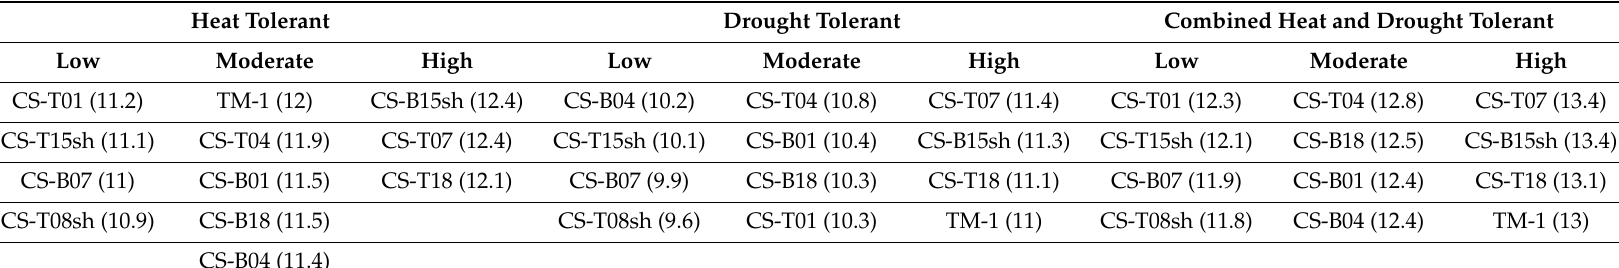
Table 3. Classification of CS lines (chromosome-specific introgressions from G. barbadense and G. tomentosum into Upland cotton ( G. hirsutum , cv. TM-1)) into drought-, heat- and combined heat and drought-tolerant groups based on the heat and drought cumulative relative response